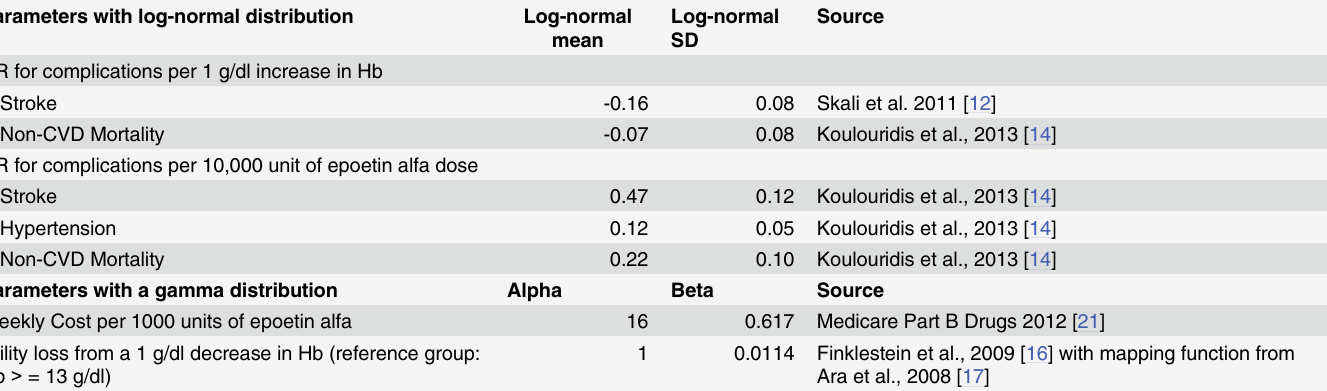
Table 2. Key parameters for probabilistic sensitivity analysis in the CKD Health Policy Model related to anemia, anemia treatment, complications of anemia and its treatment, and anemia treatment costs in persons with CKD stages 3 and 4. Parameters with log-normal distribution